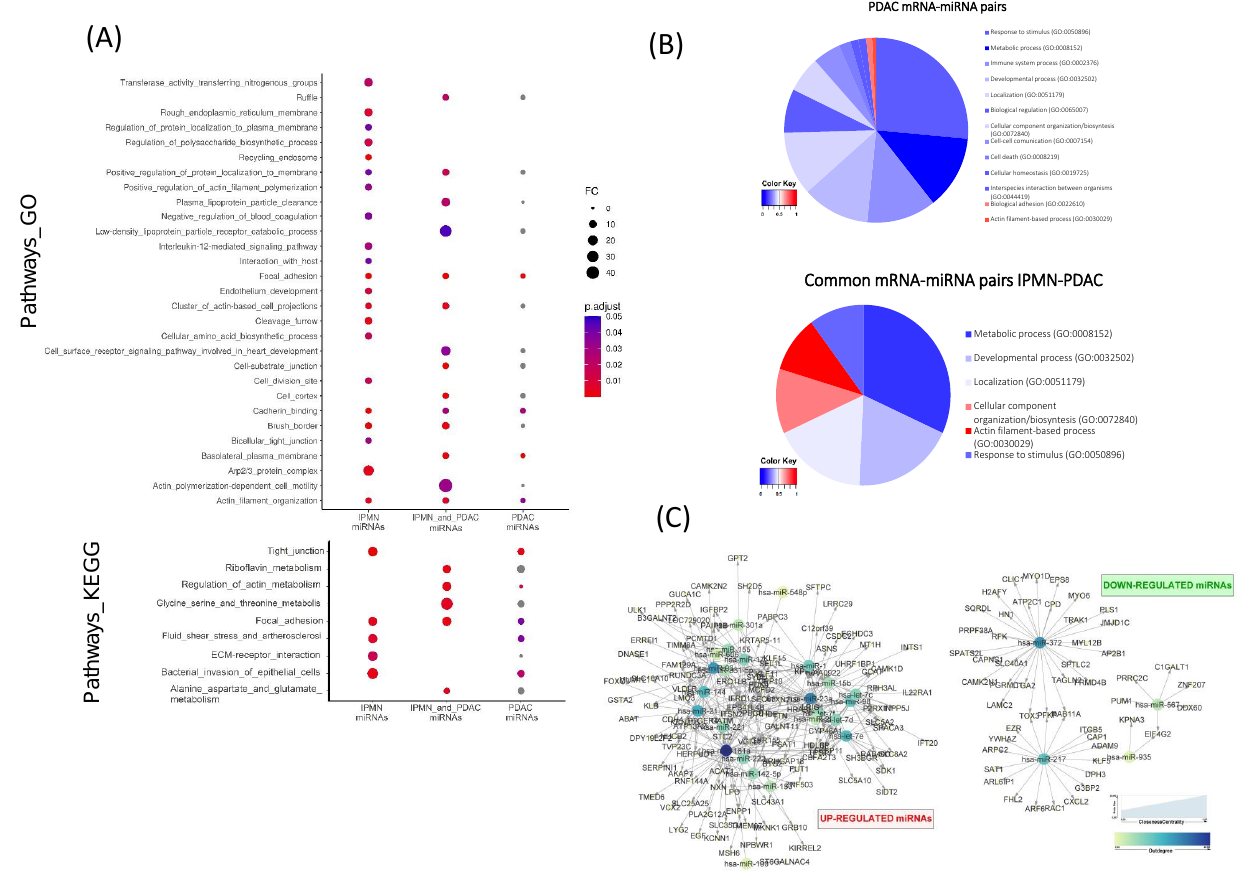
Figure 4. In silico functional and network analysis of common miRNA-mRNA interactions predicted by miRComb in IPMN and PDAC. ( A ) Dot plot showing comparative pathway enrichment analysis of IPMN miRNA-paired mRNAs (IPMN- miRNAs), miRNA-paired mRNAs commonly reported in IPMN and PDAC (IPMN_and_PDAC-miRNAs), and PDAC miRNA-paired mRNAs (PDAC-miRNAs) adj p -value < 0.05. Grey dots indicate enriched pathways with adj p -value ≥ 0.05. Gene Ontology analysis (Biological process, Cellular component, Molecular function) plus KEGG pathways results are shown. ( B ) Pie charts representing functional analysis of whole PDAC miRNA-paired mRNAs, and of only those miRNA- paired mRNAs commonly reported in IPMN and PDAC. Represented data come from Gene Ontology Biological Process report. Gradient for distribution of genes related with cell structure (cytoskeleton GO:0005856, cell adhesion GO:0007155 and extracellular matrix GO:0043062), among enriched pathways. Scores correspond to the normalized proportion of cell structure proteins from our dataset in each enriched pathways. Scores: Maximum 1 (red) minimum 0 (blue). ( C ) Network analysis of miRNA-mRNA couples commonly reported in IPMN and PDAC. Directed networks of miRNAs and mRNAs are represented. Circle size indicates Closeness to centrality; circle colours indicate outdegree (Min.-yellow, max.–dark blue). We can see two networks corresponding to upregulated miRNAs with its downregulated pairs and vice versa. Nodes with Closeness to centrality = 1 and Oudegree > 25 corresponded to hsa-miR-181a, hsa-miR-23a, hsa-miR-372 and